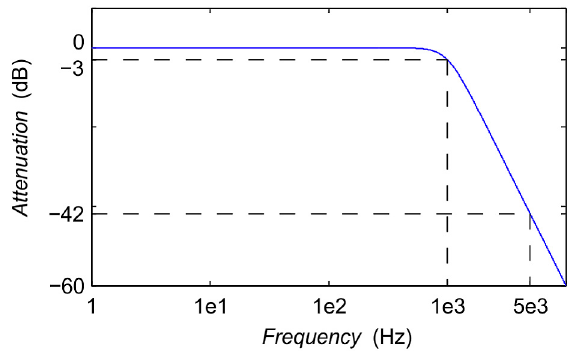
Figure 7. Bode amplitude diagram of the anti-aliasing filter.